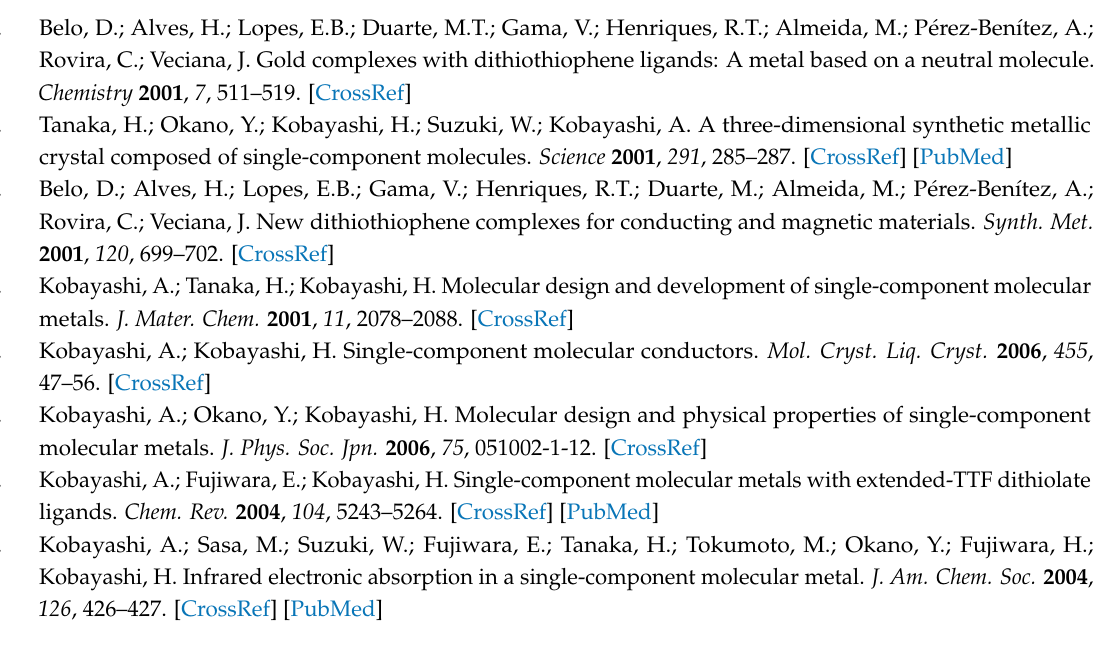
Figure S3: X-ray powder pattern of compound 4 and X-ray powder pattern simulation of compound 3 , X-Ray structural analysis of ligand precursor 1 , Figure S4: Crystal structure of compound 1 , Table S1: Bond lengths of compound 3 , Table S3 and Table S4: Bond lengths of compound 5 , Table S2 and Table S5: Short contacts of compounds 3 and 5 ,